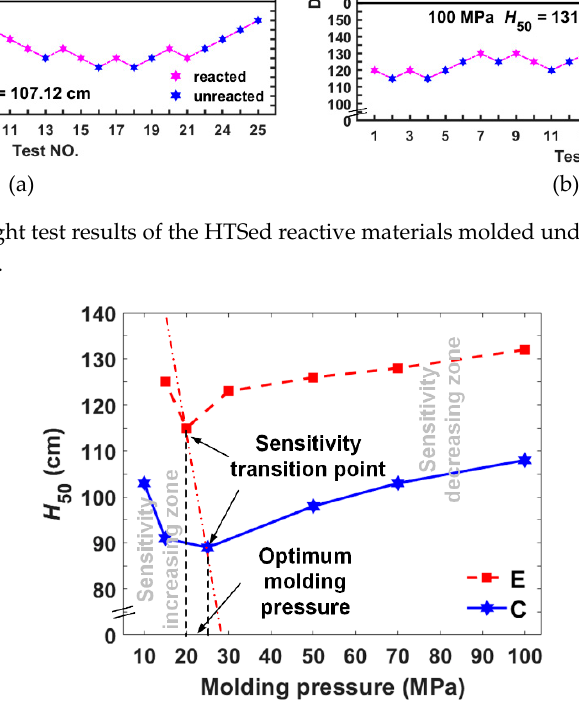
Figure 12. Drop weight test results of the HTSed reactive materials molded under different pressures: ( a ) type C; ( b ) type E.